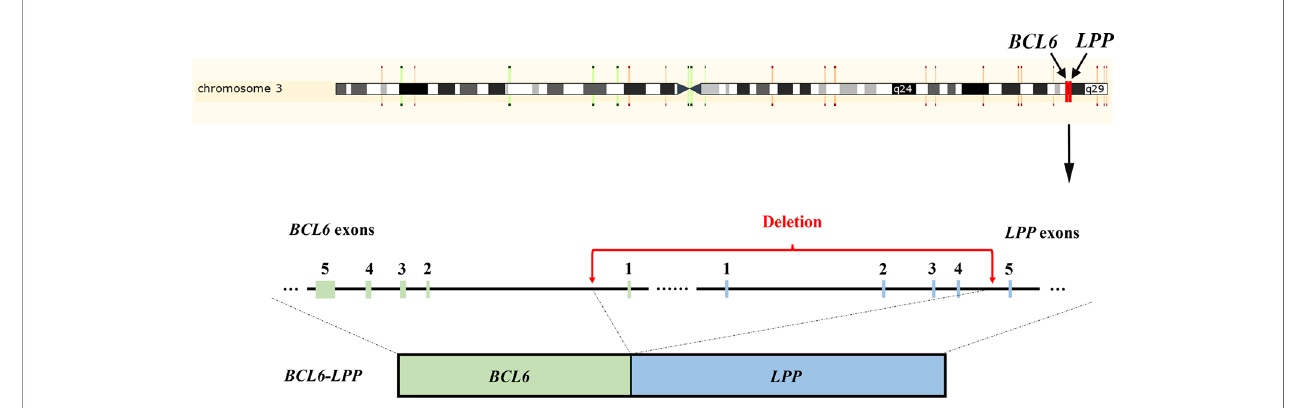
FIGURE 4 | Schematic representation of the BCL6-LPP fusion in Case 2. An 838 kb-sized deletion of chromosome 3q27.3 – 3q28 (base 187461439 on chromosome 3q27 to base 188299507 on chromosome 3q28), resulting in a fusion of the BCL6 with the LPP gene.